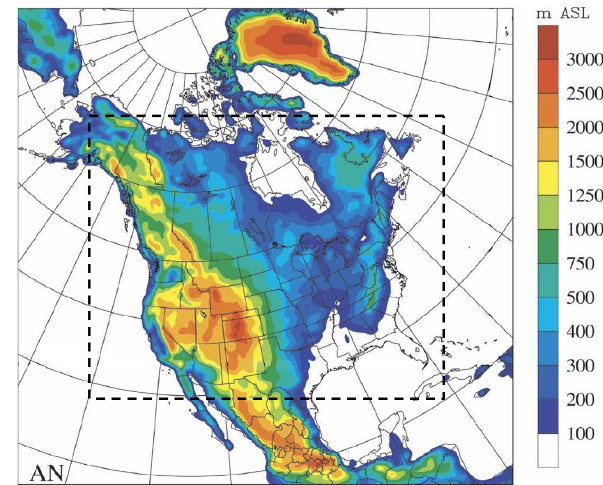
Fig. 1. CRCM and (within dashed line) AURAMS-CRCM grids, CRCM topography field